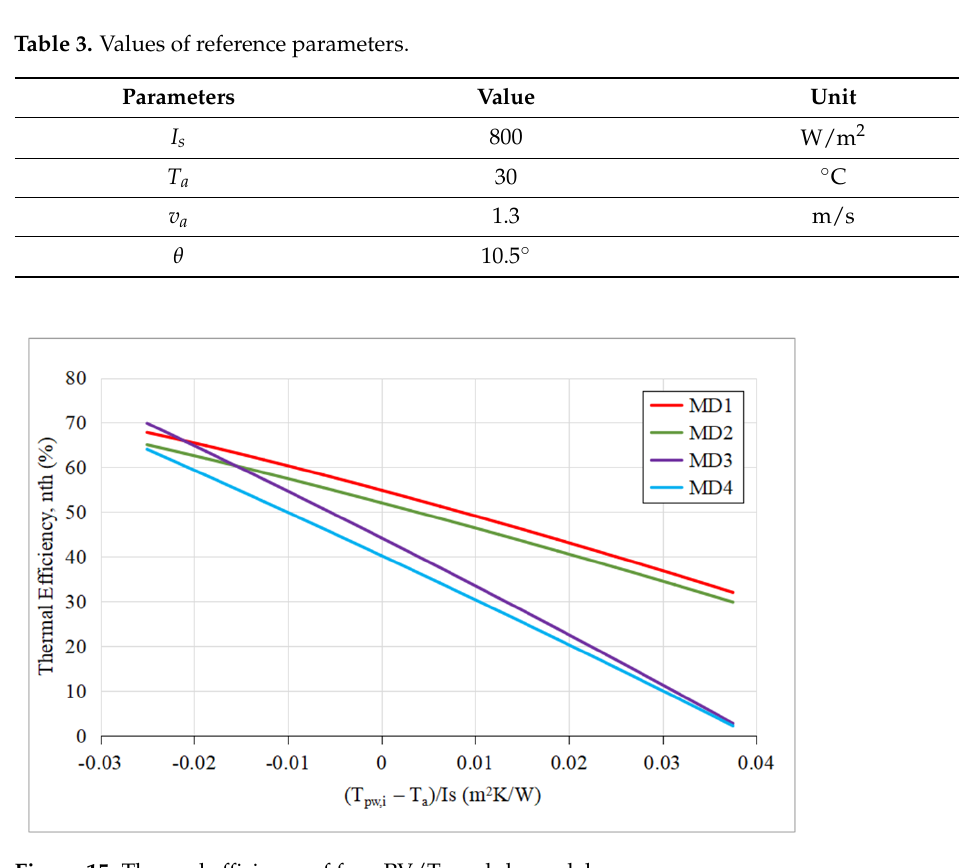
Figure 16. Electrical efficiency of four PV/T module models. Table 4. Thermal and electrical efficiency formula of four PV/T module models. 4 Models of PV/T Module